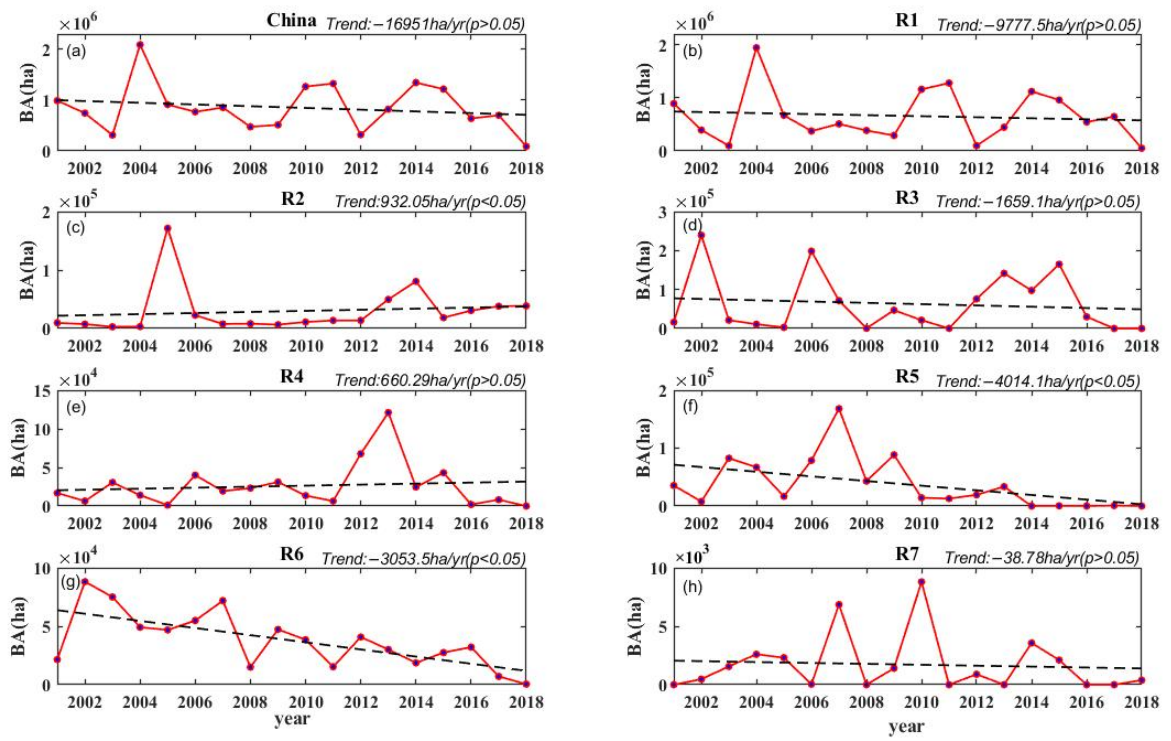
Figure 7. The trends of the BA in China and R1–R7 in autumn. In winter, R1 (2295.8 ha/yr) and R6 (40.03 ha/yr) show significantly increasing trends, while R4 ( − 608.81 ha/yr), R5 ( − 7632.3 ha/yr) and R7 ( − 226.82 ha/yr) show significantly de-